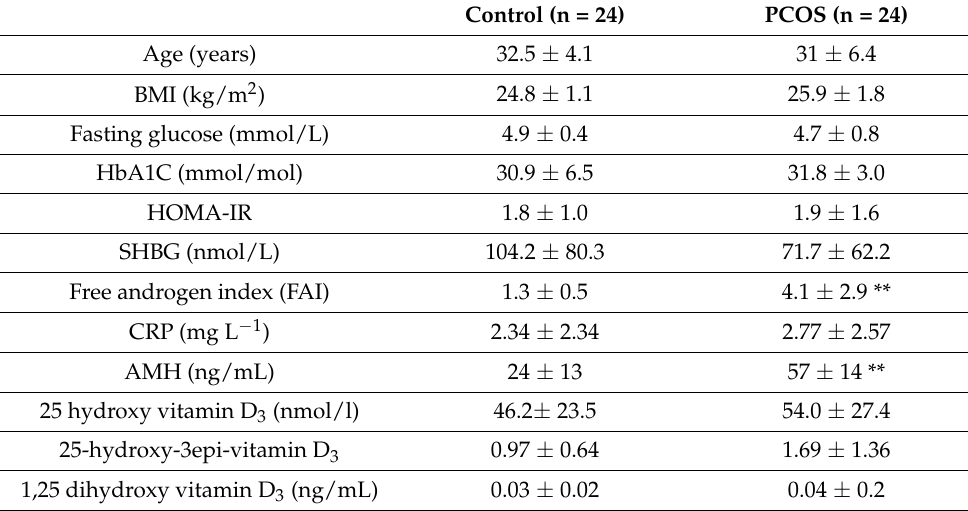
Table 1. Demographics, baseline, hormonal and metabolic parameters of the PCOS subjects and controls (mean ±